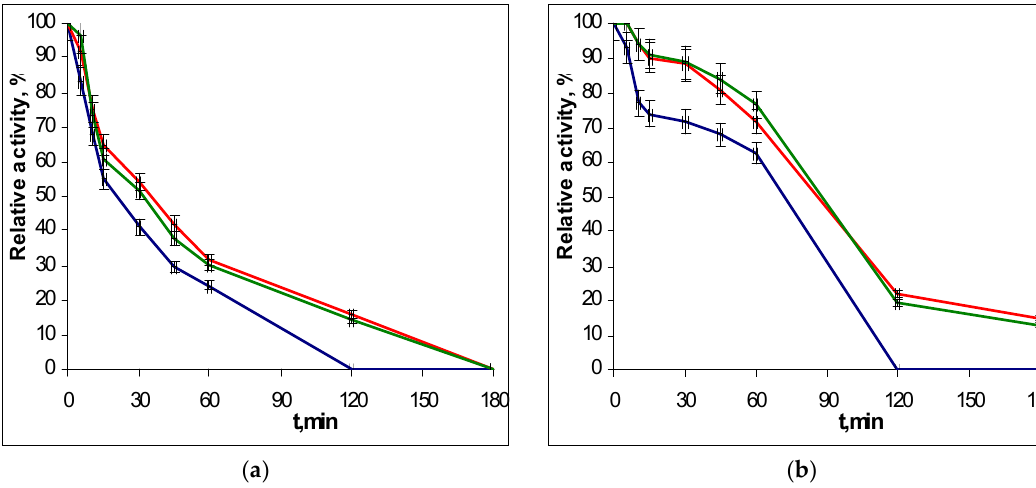
Figure 4. The thermoinactivation of EGLII-wt (blue line) and its DSB2 (red) and DSB3 (green) variants at pH 5.0 and 80 °C: ( a ) Residual activity against CMC and ( b ) the residual activity against β-glucan. The enzyme initial activity is taken as 100%.